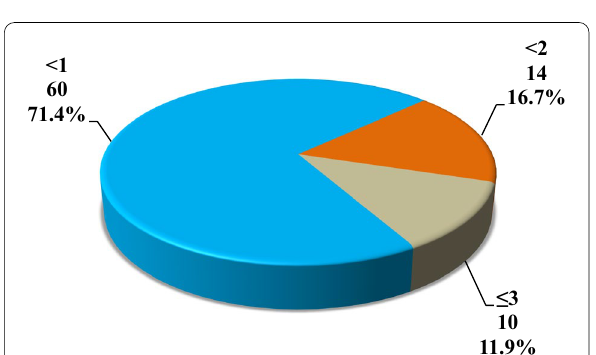
Fig. 5 Distribution of the studied cases according to difference